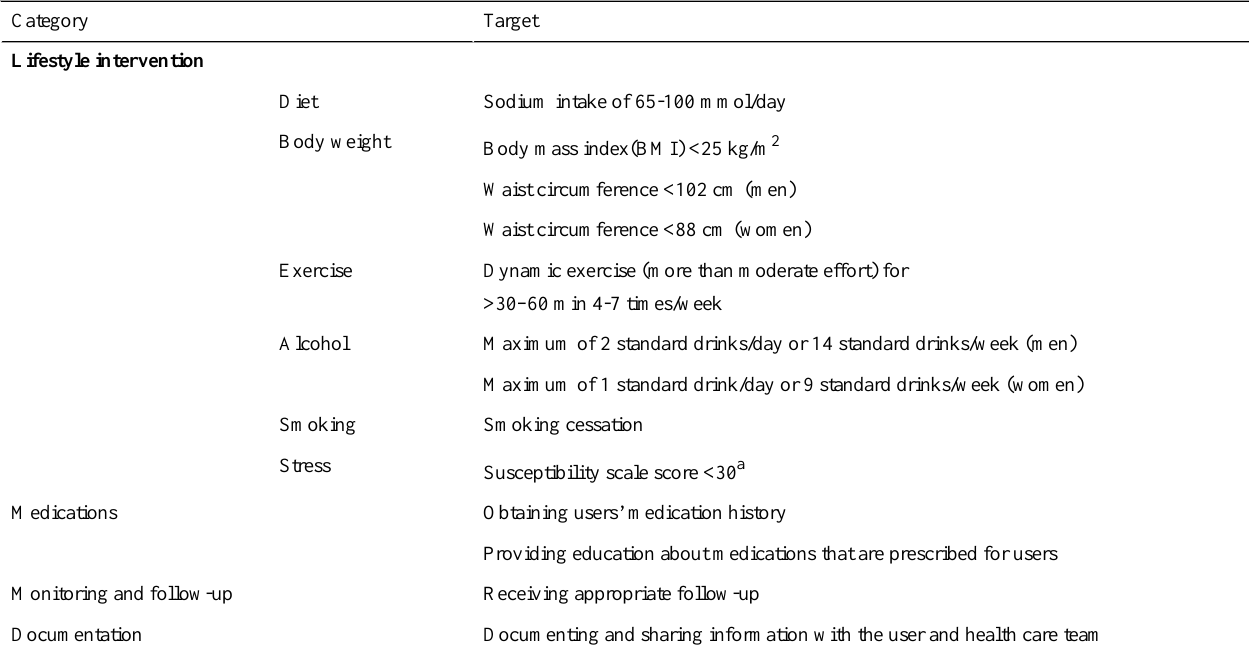
Table 2. Intervention categories and targets [20,22].